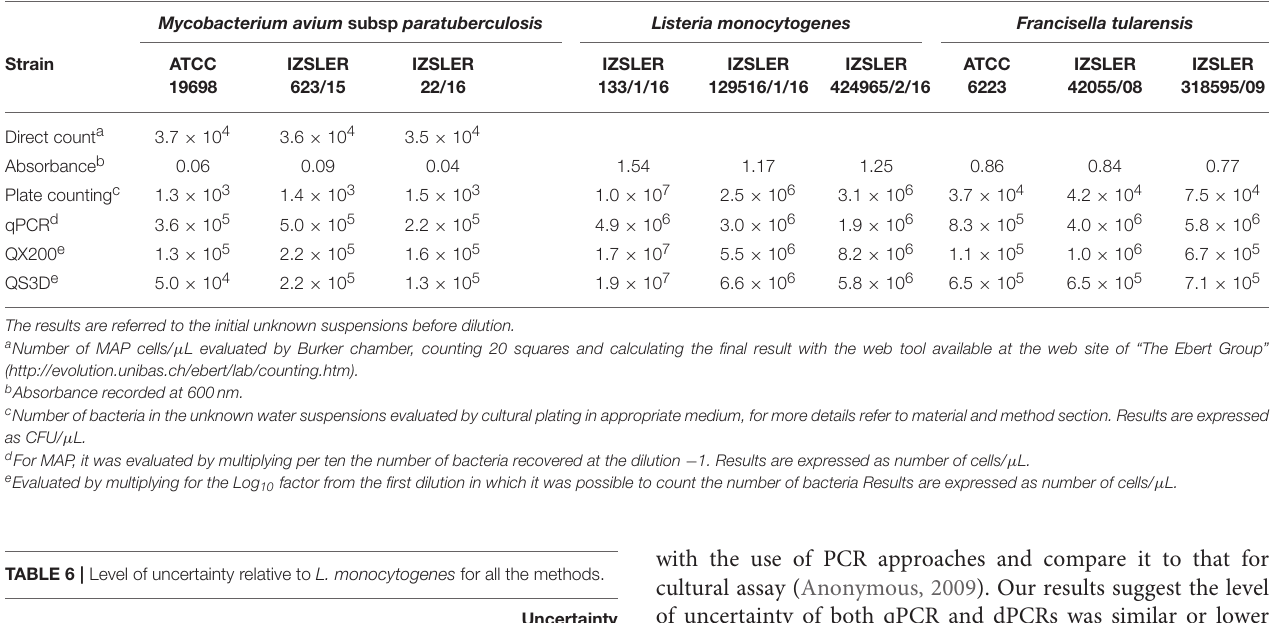
TABLE 5 | Quantification of the unknown water suspensions carried out by PCR approaches and non-molecular methods.